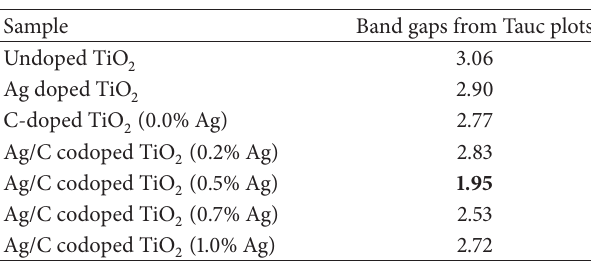
Table 2: Band gaps of undoped TiO 2 , Ag doped TiO 2 , and Ag/C codoped TiO 2 with different contents of Ag.